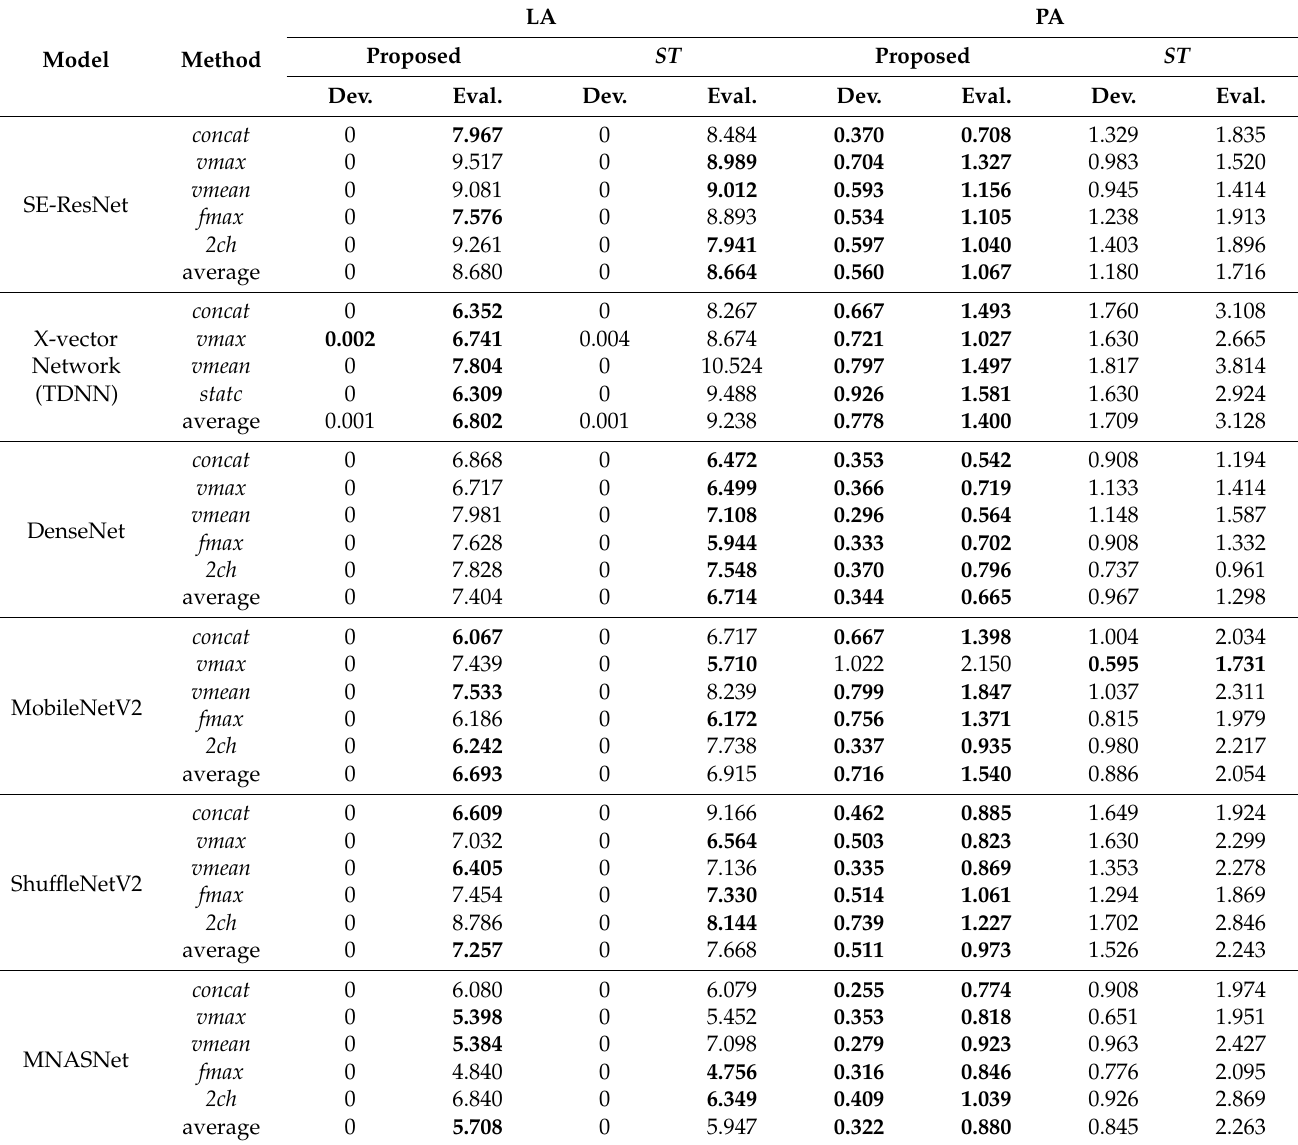
Table 2. Oracle EERs (%) of systems on the development and evaluation trials of ASVspoof 2019 LA and PA scenarios, with the proposed and ST methods. For each model, the lowest EER is highlighted in